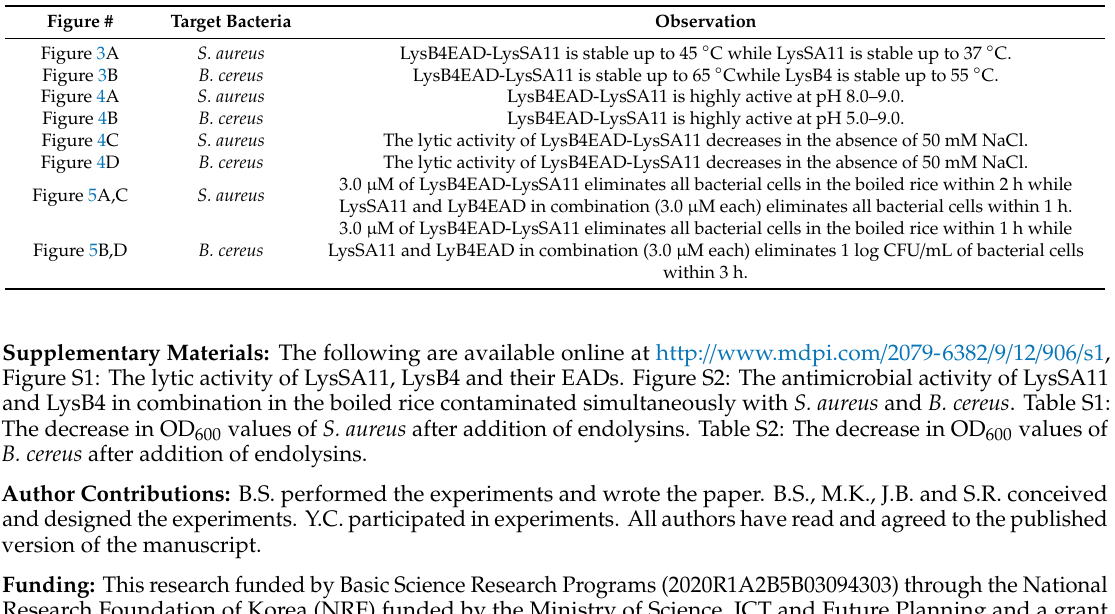
Table 3. Results summary. Target Bacteria Observation